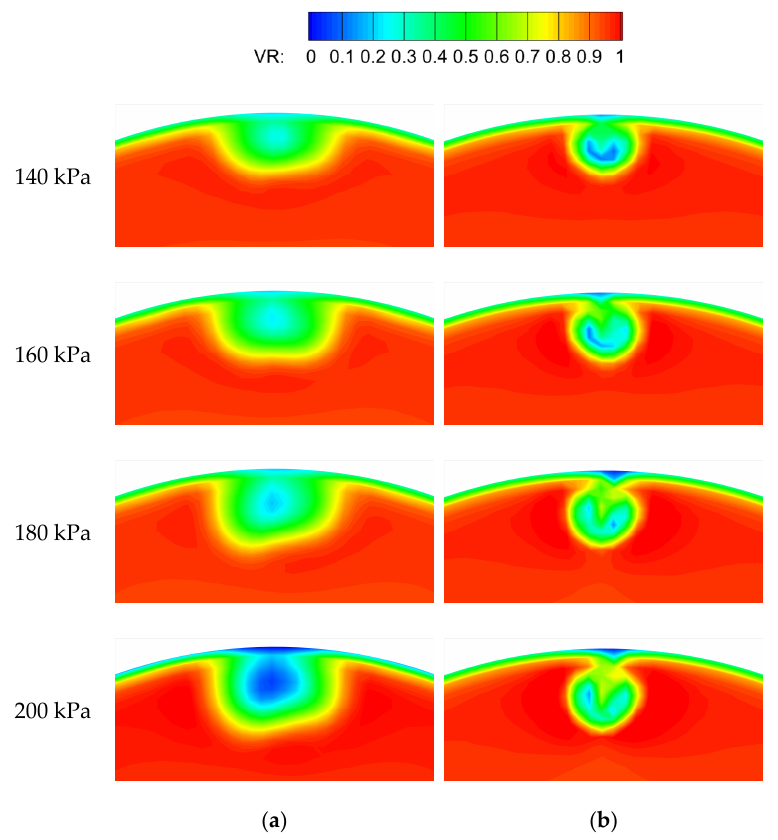
Figure 13. Time-averaged velocity magnitude at the exit section for various cases: ( a ) fluidic oscillator, ( b ) air tab.